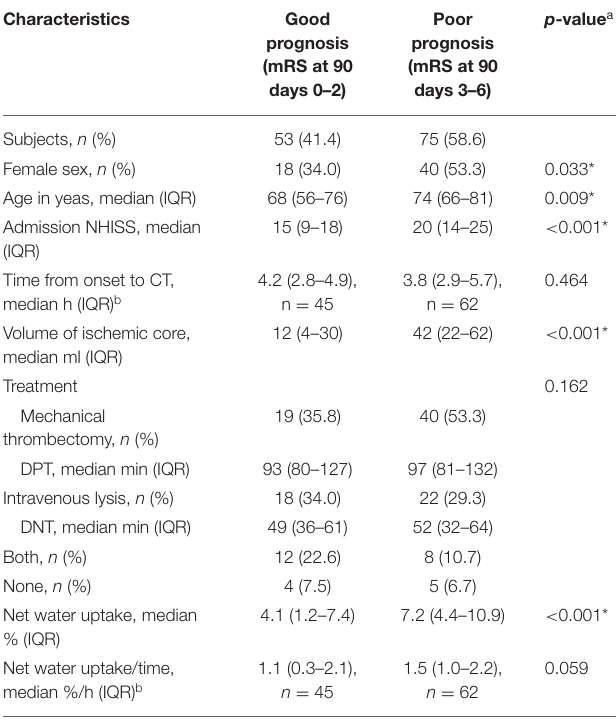
TABLE 2 | Characteristics of patients with anterior circulation infarct stratified by prognosis.